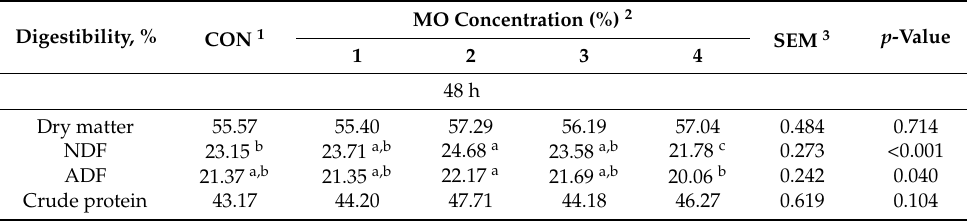
Table 3. Effect of 3% rumen-protected microencapsulated supplement (MO) on digestibility in the in vitro ruminal